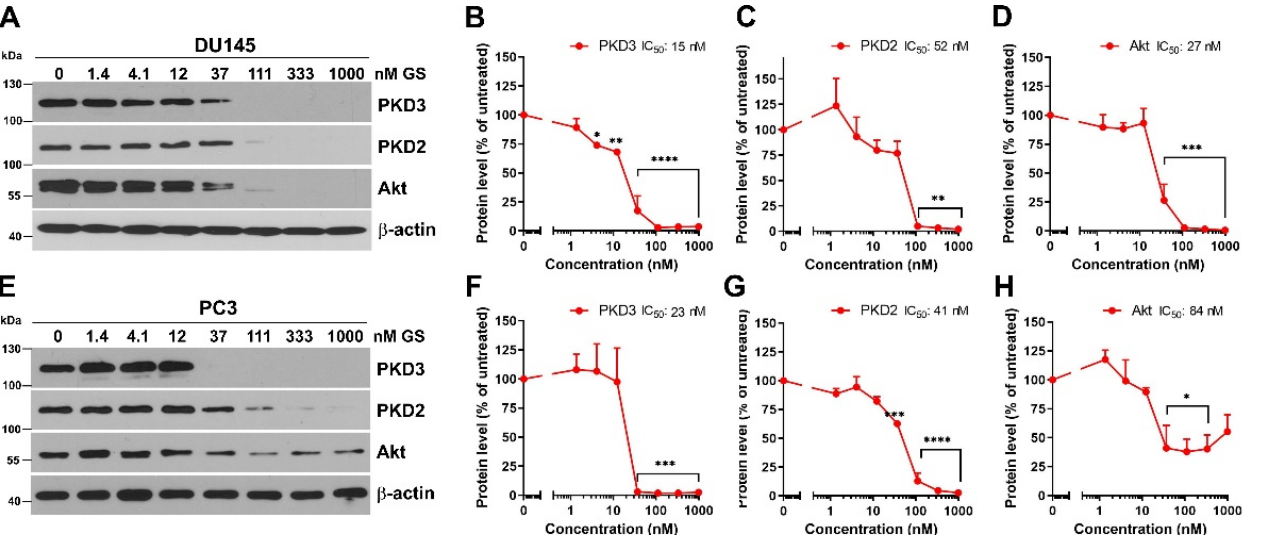
Figure 2. Hsp90 inhibition depletes PKD3 protein in prostate cancer cells. Western blots of lysates from DU145 ( A ) and PC3 ( E ) cells treated with GS for 48 h. Densitometric analysis and IC 50 calcula- tion (mean ± SEM) from DU145 ( B – D ) and PC3 ( F – H ) cells from three (or two, panels ( C , D , H )) in- dependent experiments. * p < 0.05, ** p < 0.01, *** p < 0.001, **** p < 0.0001, (two-way ANOVA with Tukey’s multiple comparison test). Western blot images are representatives of three (or two, panels ( C , D , H )) independent experiments.